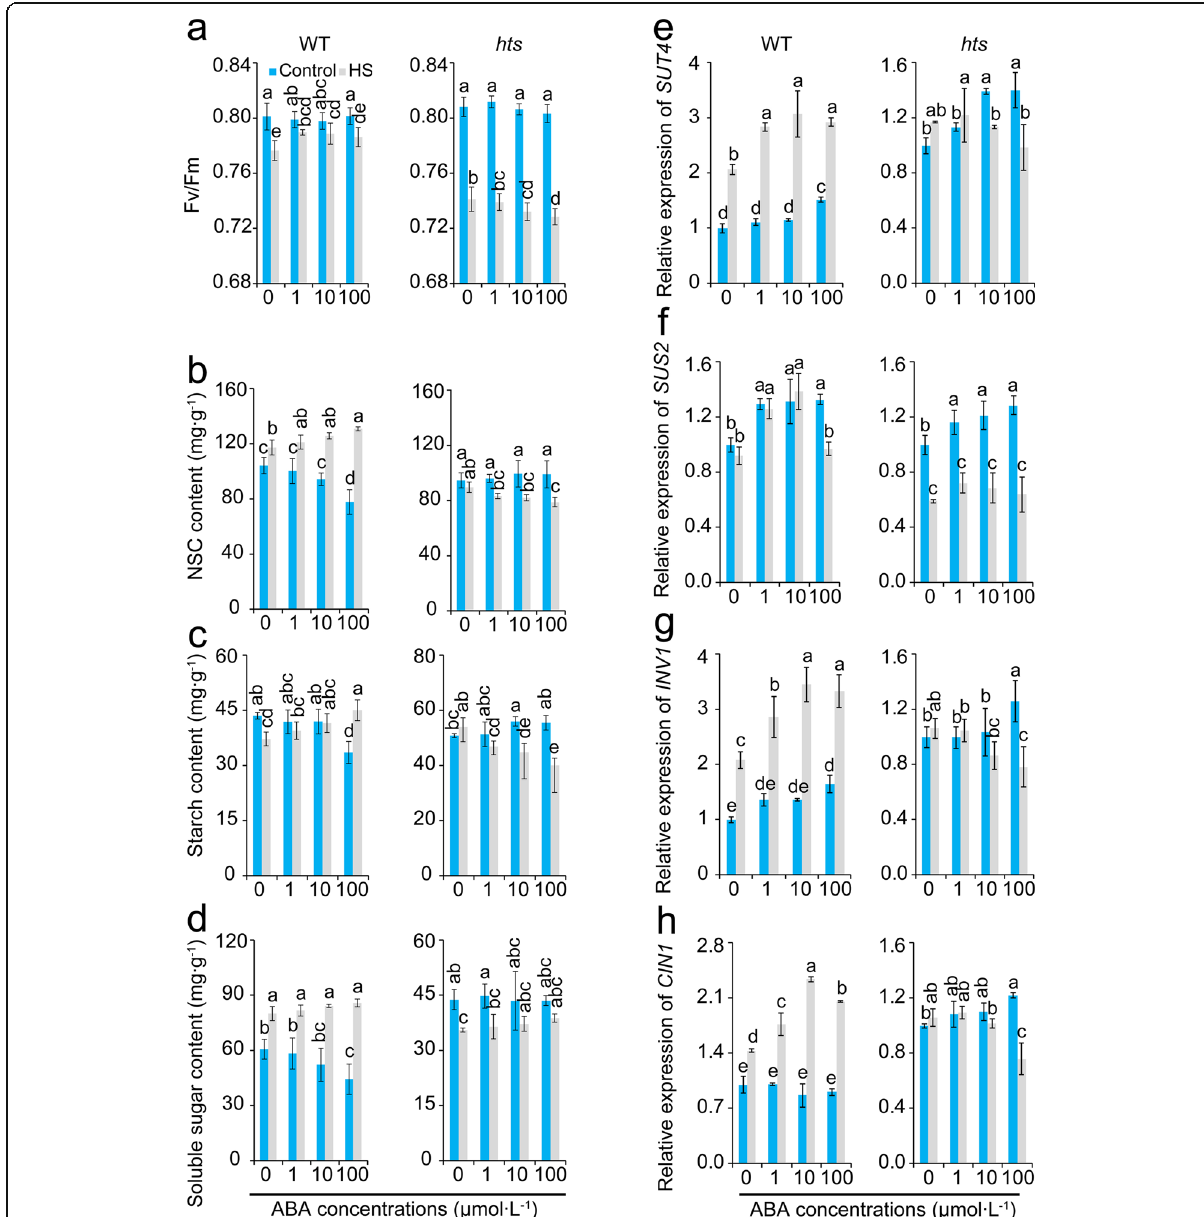
Fig. 7 Effect of ABA on Fv/Fm, carbohydrate content and metabolism of leaves in rice plants under heat stress. a , Fv/Fm; b , NSC content; c , starch content; d , soluble sugar content; e , Relative expression level of SUT4 ; f , Relative expression level of SUS2 ; g , Relative expression level of INV1 ; h , Relative expression level of CIN1 . Vertical bars denote standard deviations ( n = 3). Different letters indicate a significant difference among ABA treatments under the control and heat-stressed conditions within a genotype by two-way analysis of variance for two factors (temperature and treatment) ( P <